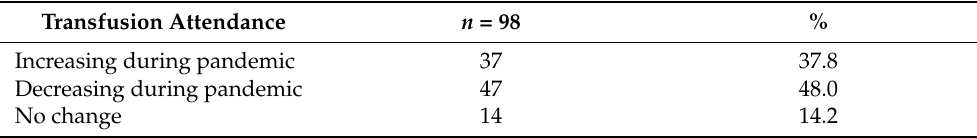
Table 4. Change of transfusion attendance during pandemic.